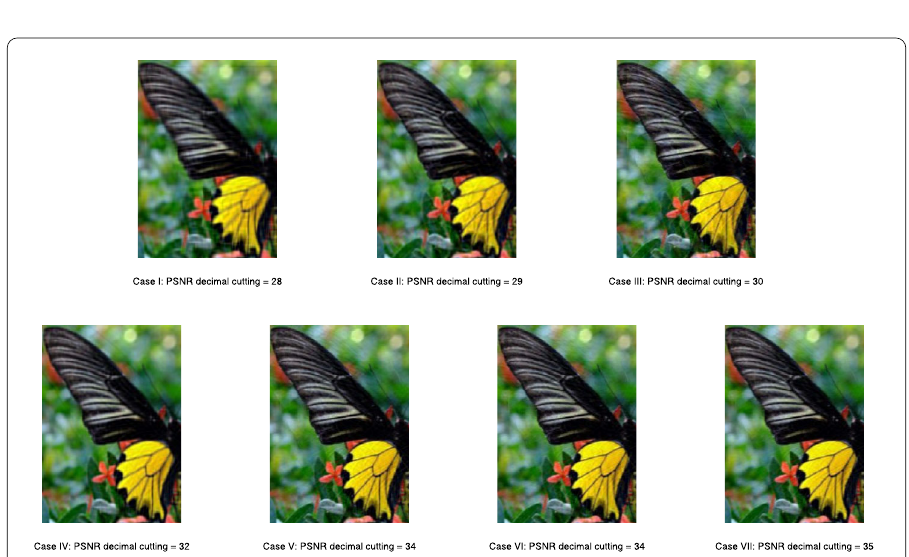
Figure 5 The reconstructed RGB image with its PSNR (decimal cutting) for all cases with the proposed algorithm being used, after 500 iterations